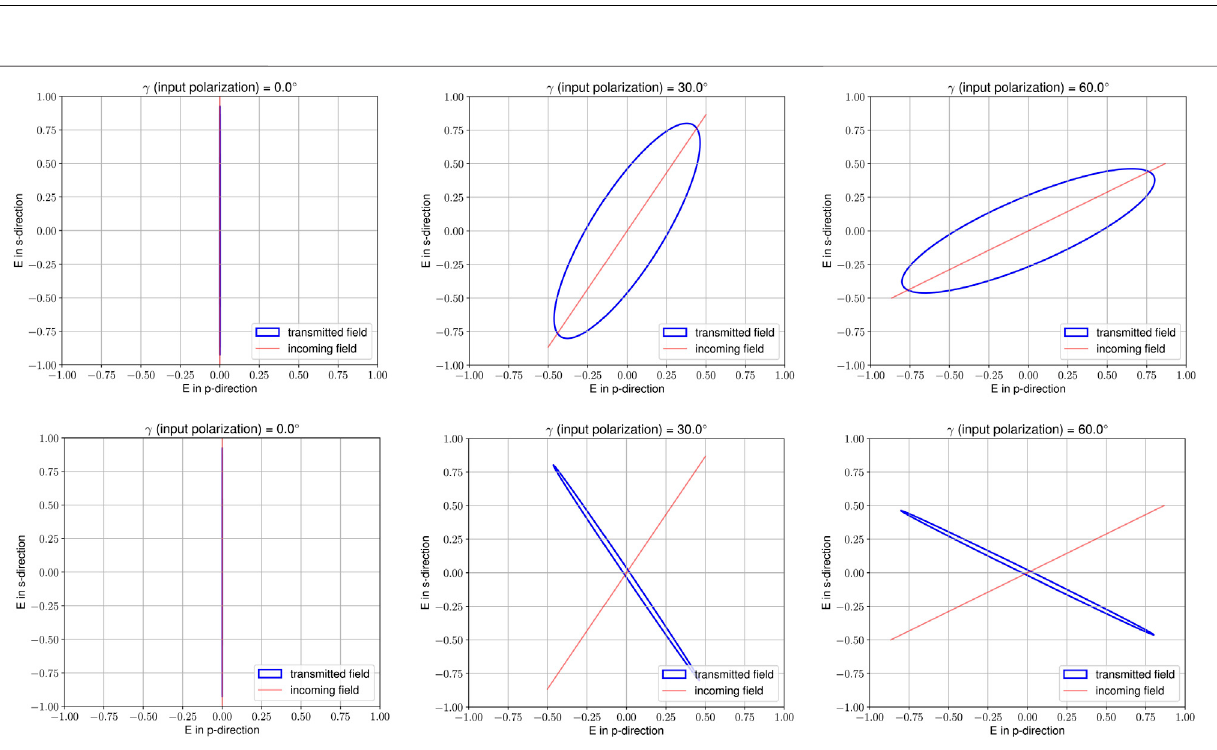
Frontiers in Astronomy and Space Sciences |